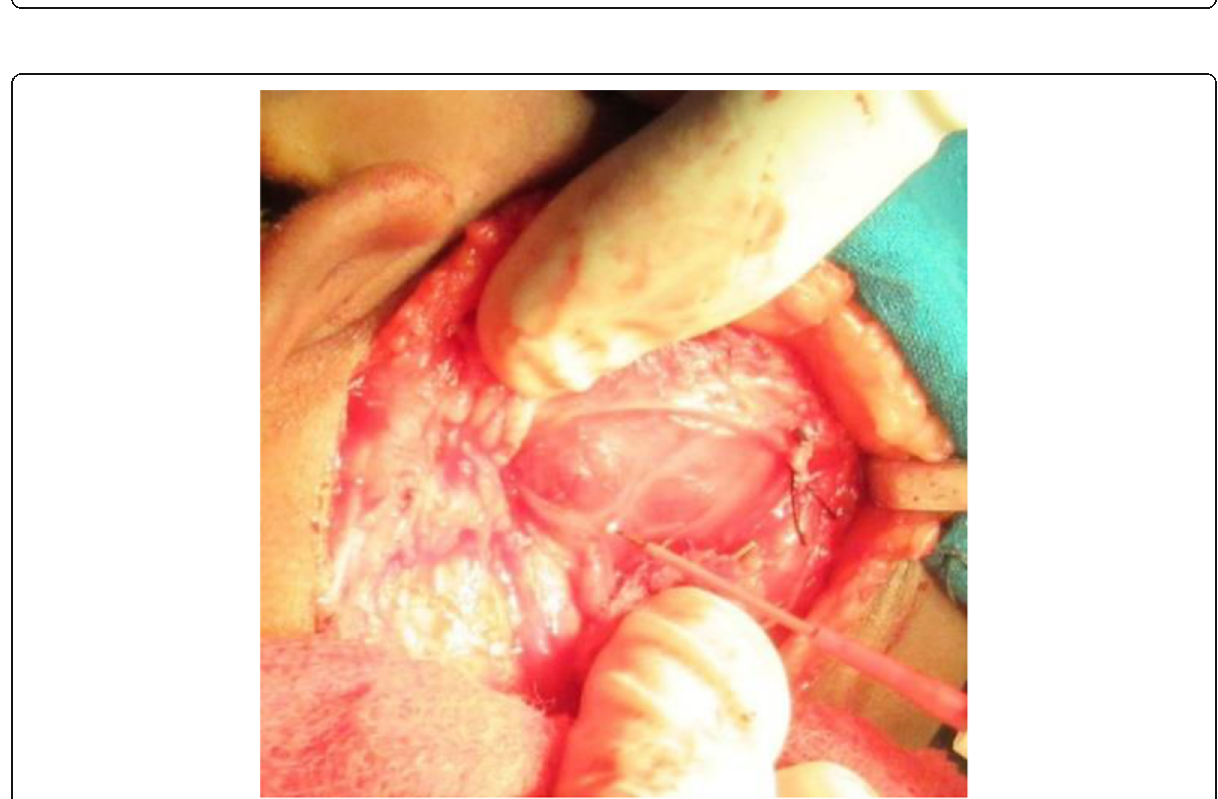
Fig. 16 Pterygo-masseteric sling